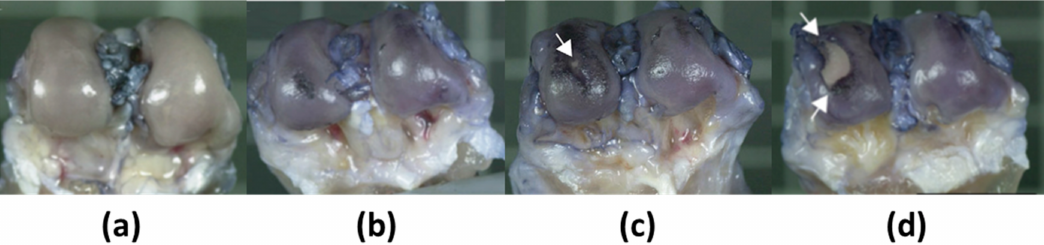
Figure 5. Different scores of Indium ink test. ( a ) Grade 1: cartilage intact surface, normal surface, and no retention of Indium ink. ( b ) Grade 2: cartilage minimal fibrillation; surface retains Indium ink as elongated specks or light-gray patches. ( c ) Grade 3: cartilage overt fibrillation; areas velvety in appearance and retains Indium ink as intense black patches. ( d ) Grade 4: cartilage erosion; loss of cartilage exposing the underlying